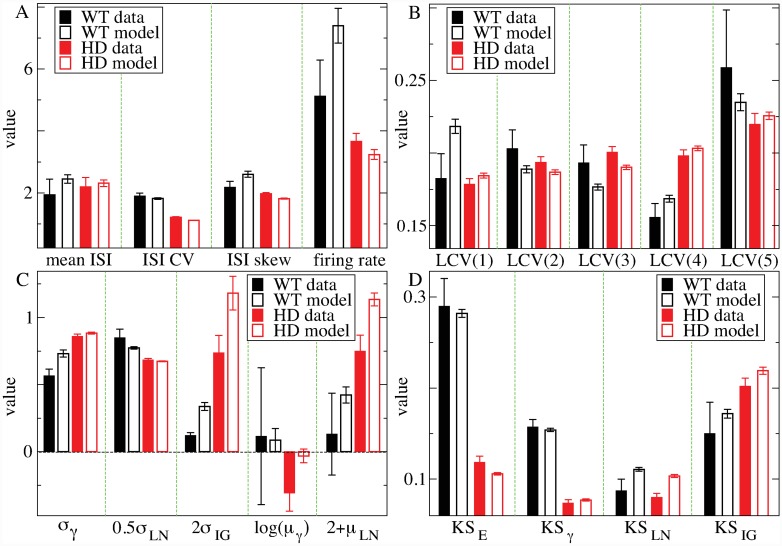
Comparison of ISI statistical quantities for the YACWT restricted age dataset denoted, ‘WT75’, (solid black), and the YACHD restricted age dataset denoted ‘HD12’ (solid red), whose log KL heat maps are shown in Fig 6(f) and 6(i) and whose ISI characteristics are shown in Fig 9(a), 9(c) and 9(e), and the same summary statistics from the best fit network models (WT empty black, HD empty red) indicated by crosses in Fig 6(f) and 6(i) whose ISI characteristics are shown in Fig 9(b), 9(d) and 9(f).ISI statistical quantities are the same as those described in Fig 1. (a) mean ISI μ, ISI CV σ/μ, ISI rescaled skew S/CV (labelled ‘ISI skew’), firing rate, r, (b) five quintiles of the ISI local CV distribution, LCV(j)j = 1, .., 5, (c) shape parameters for gamma, σγ, log normal, 0.5σLN, and inverse-Gaussian, 2σIG, distributions, scale parameters for gamma, ln(μγ), and log normal, 2 + μLN, distributions (transformations for plotting convenience), (d) KS distance between the data and four maximum likelihood distributions, exponential, KSE, gamma, KSγ, log-normal, KSLN, and inverse-Gaussian, KSIG. Results shown are averages across all individual spike trains with more than 10 spikes in each of the four datasets (two experimental and two model) and bars show the SEM in these averages (see Methods).